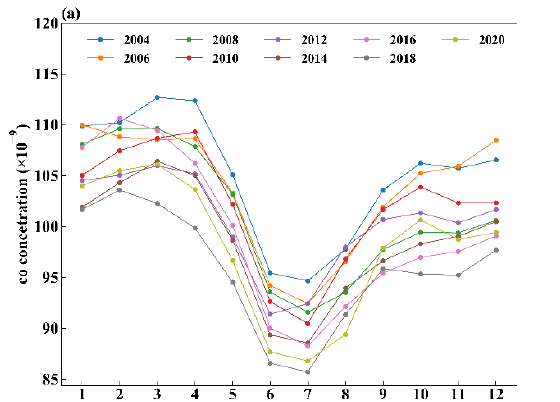
Figure 2. Spatial distribution and latitudinal variation curve of average CO concentration in different pressure layers in the world from January 2003 to December 2020. ( a , b ) 850 hPa; ( c , d ) 500 hPa; ( e , f ) 100 hPa.